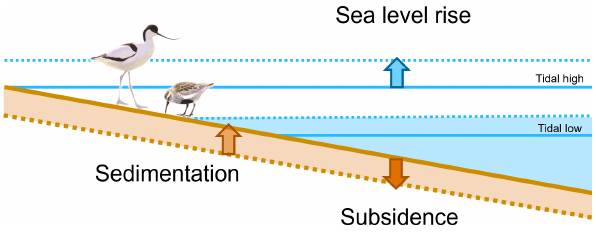
Figure 2. When subsidence and sea level rise are balanced by (ex- tra) sedimentation, the intertidal flats are maintained, and the natural values are likely